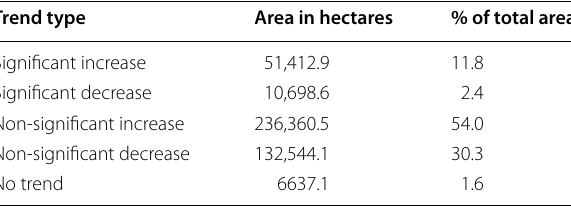
Table 2 Watershed level trend in vegetation